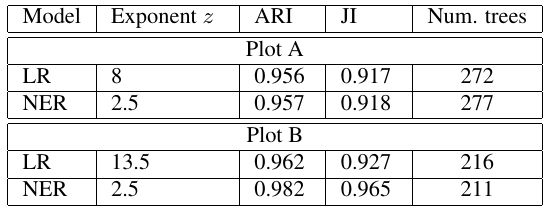
Table 4: Segmentation quality - learning from virtual